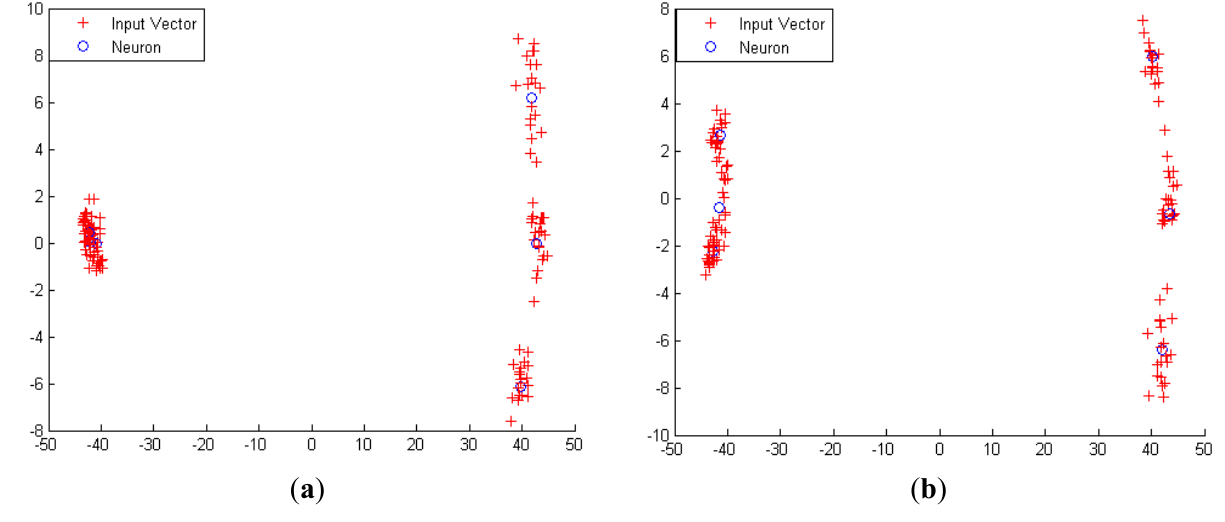
Figure 14. The graphical representation of LDA-CLNN with ( a ) 6 neurons of e-nose data ( b ) 6 neurons of fused e-nose and acoustic data on six different maturity and ripeness level.